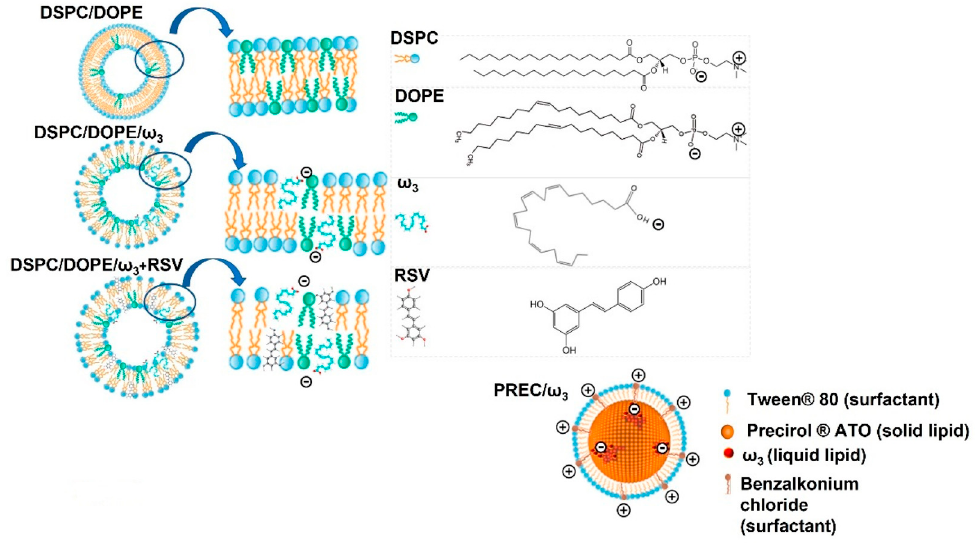
Figure 3. Schematic representation of lipid nanosystems with or without RSV and ω 3